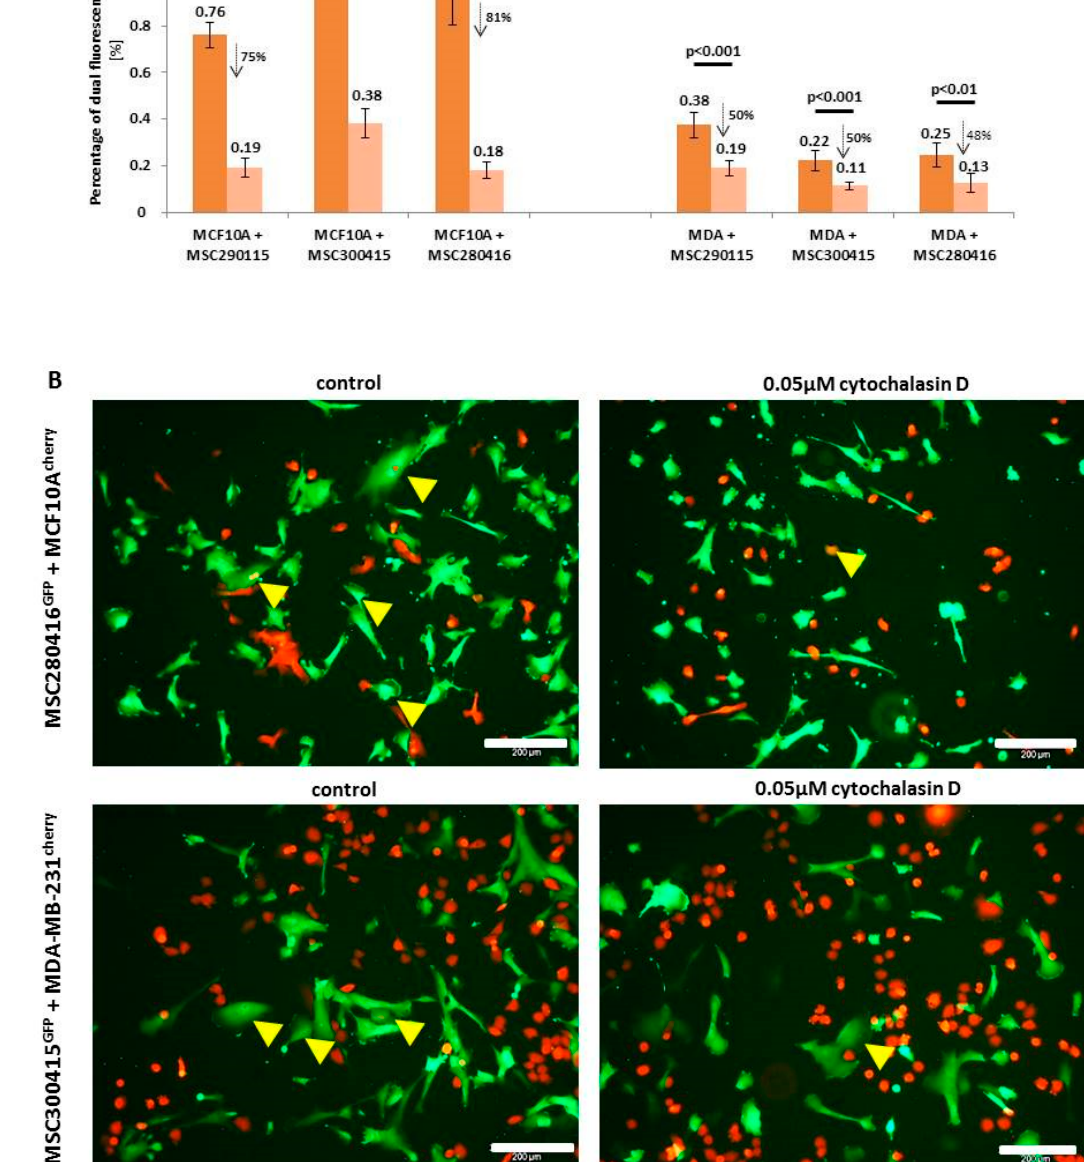
Figure 1. Effect of actin polymerization inhibitor on hybrid cell formation. ( A ) Initially, 6000 cells per well (50:50) of co-cultures between MSC GFP from three different donors (MSC290115, MSC300415, and MSC280416), as well as MCF10A cherry or MDA-MB-231 cherry were started overnight to allow attachment. After 24 h, co-cultures were treated with either 0.05 µM cytochalasin D or a solvent concentration of DMSO, and the percentage of dual fluorescent cells was determined after 24 h of treatment. Data represent the mean ± SD from n = 6, and significances were calculated using a Student ′ s t -test. ( B ) Fluorescence microscopy of co-cultures between MSC280416 GFP and benign MCF10A cherry neoplastic breast epithelial cells (left panel) and fluorescence microscopy of co-cultures between MSC300415 GFP and malignant MDA-MB-231 cherry breast cancer cells (right panel) are exemplarily demonstrated in control co-cultures (stimulated with solvent concentration of DMSO), and in the presence of 0.05 µM cytochalasin D for 24 h. Scale bars: 200 µm.